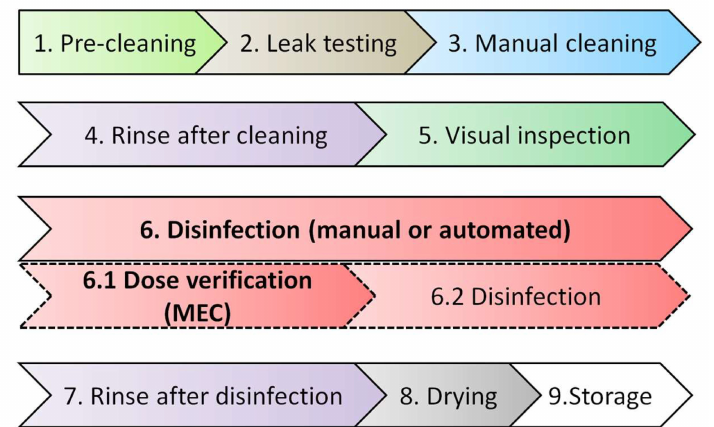
Figure 10. Scheme of endoscope reprocessing steps. Step 1: Pre-cleaning removes organic material and decreases the bioburden. Step 2: Leak testing detects damage to the endoscope’s interior channels and exterior surfaces. Step 3: The most critical step in removing the microbial burden from an endoscope. Step 4: Remove residual debris and detergent with de-ionized water. Step 5: Use magnification and adequate lighting to assist in visual inspection to ensure the endoscope is visibly clean. Step 6: Disinfectants must be tested to ensure they remain above their MEC. Step 7: Thoroughly rinse all surfaces of parts with de-ionized water. Step 8: Flushed with 70% to 90% ethyl or isopropyl alcohol before drying with pressurized, filtered air. Step 9: Endoscopes must be stored in a clean, well-ventilated, and dust-free area. Adopted and rewritten from ‘Standards of Infection Prevention in Reprocessing Flexible Gastrointestinal Endoscopes’, The Society of Gastroenterology Nurses and